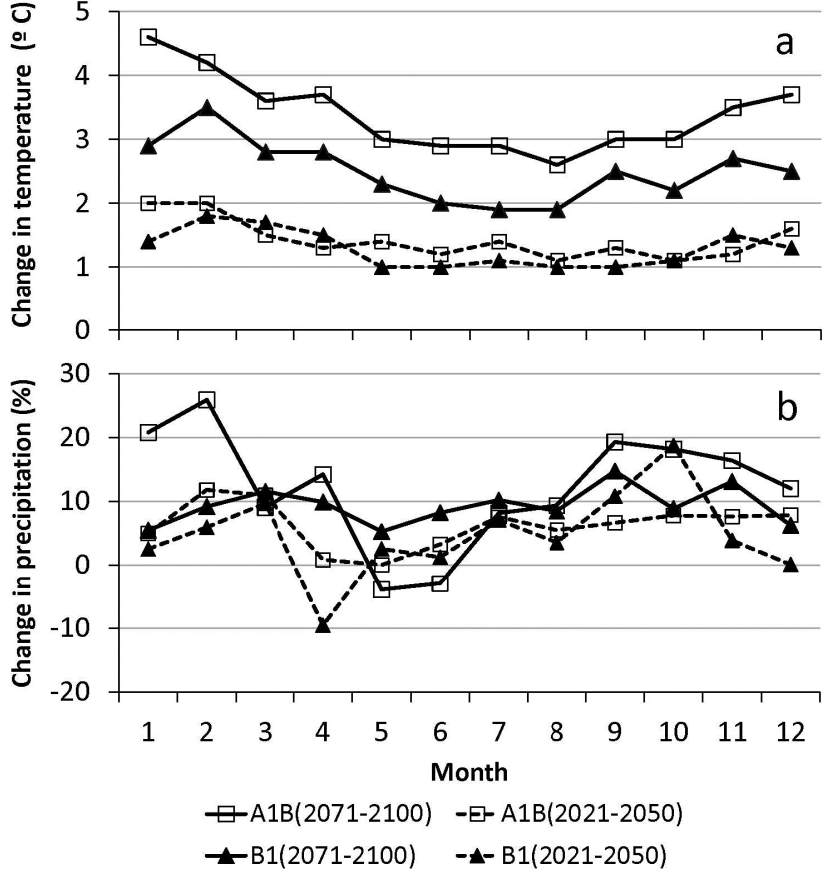
Figure 8. Change in ( a ) mean monthly temperature and ( b ) mean monthly precipitation